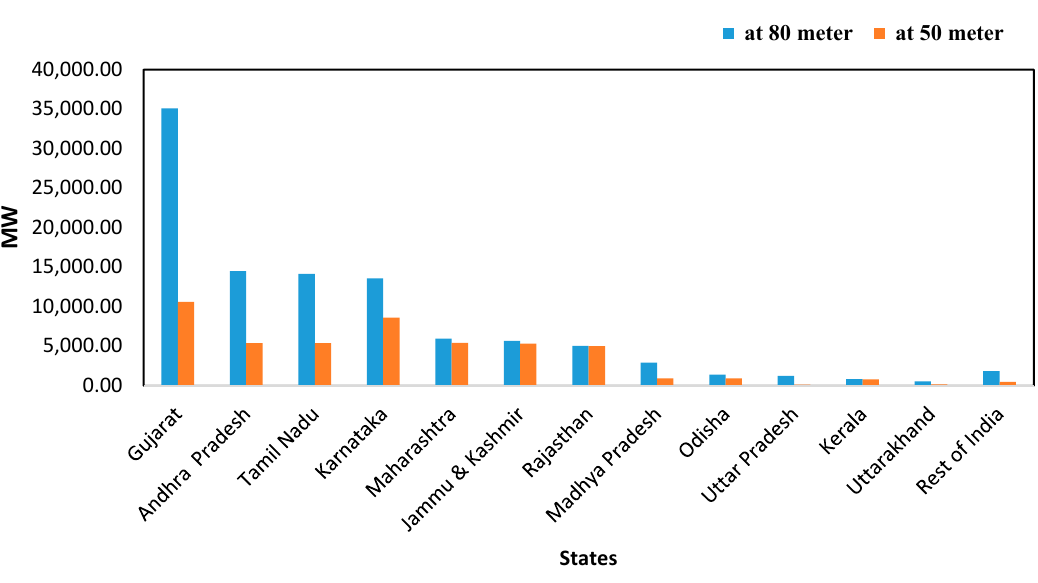
Figure 1. Solar radiation in India [23].